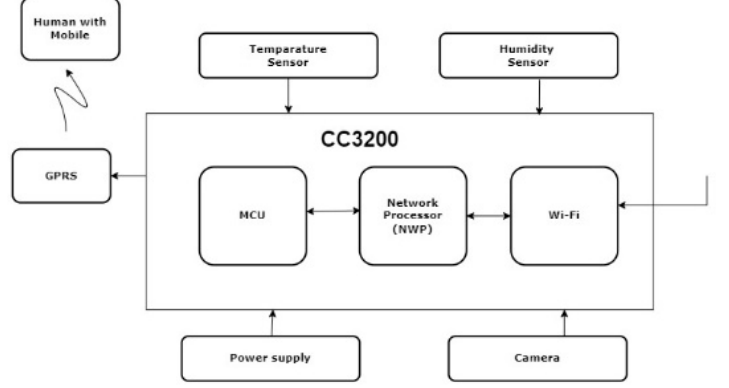
Figure 3. Block diagram of IOT Based System proposed by Prathibha S R et al.